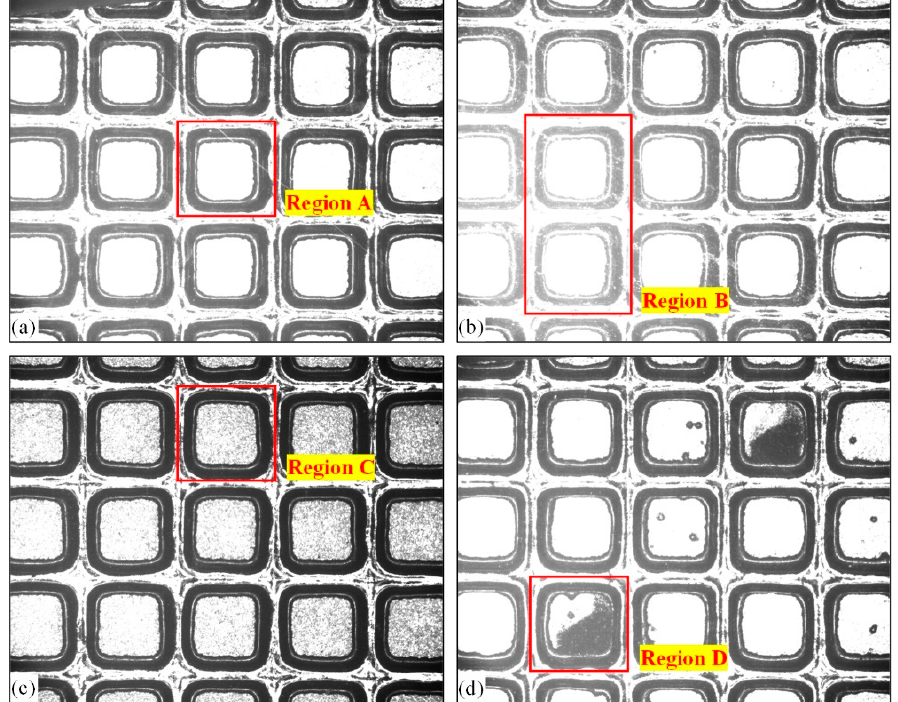
Figure 4. Classification of wafer images. ( a ) Wafer images classified as category 1; ( b ) wafer images classified as category 2; ( c ) wafer images classified as category 3; ( d ) wafer images classified as category 4.